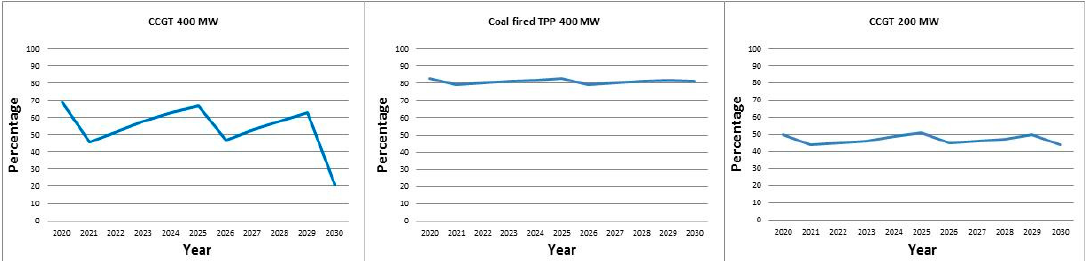
Figure 7. Load factor of new power plants in a scenario with the least cost planning (LCP) algorithm and VOLL of $10 USD/kWh.